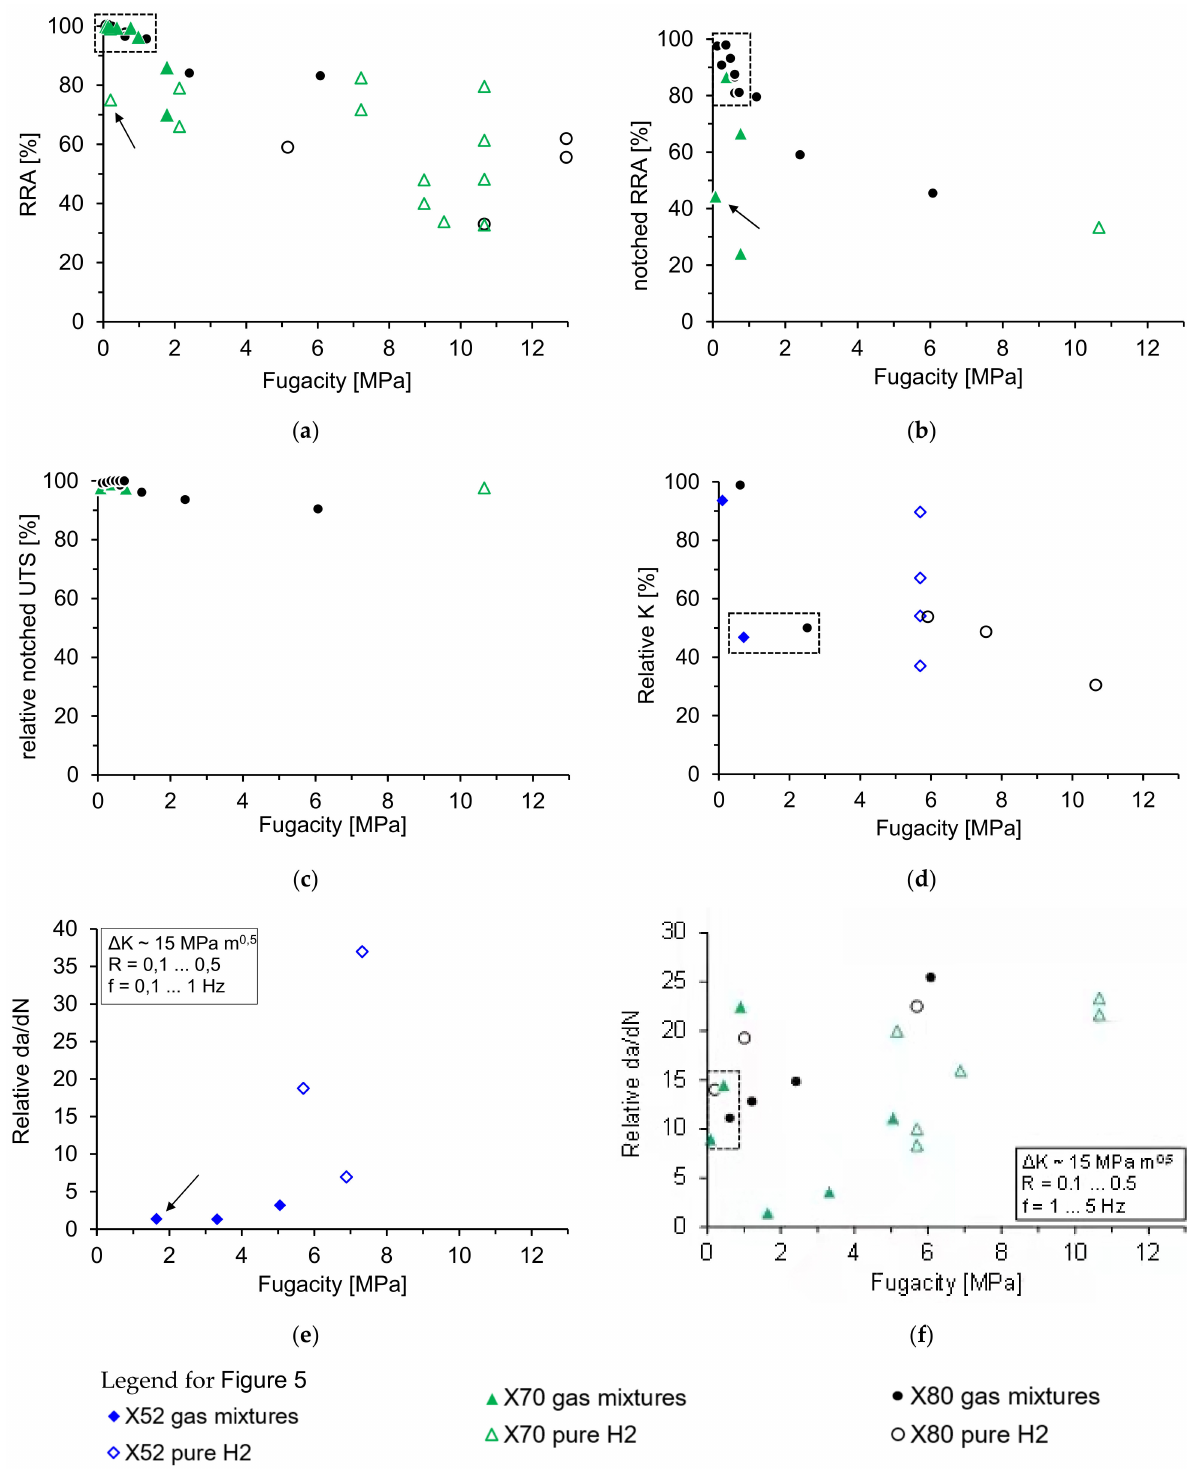
Figure 5. HEI as a function of hydrogen fugacity. ( a ) Tensile RRA of smooth specimens for X70 and X80 steels data from [6,8,9,26–36]. ( b ) Tensile RRA of notched specimens for X70 and X80 steels data from [7–9,37,38]. ( c ) Relative notched ultimate tensile strength for X70 and X80 steels data from [7–9,37,38]. ( d ) Relative fracture toughness (K) for X52 and X80 steels data from [39–45]. ( e ) Relative crack growth rate for X52 and ( f ) Relative crack growth rate for X70 as well as X80 steels data from